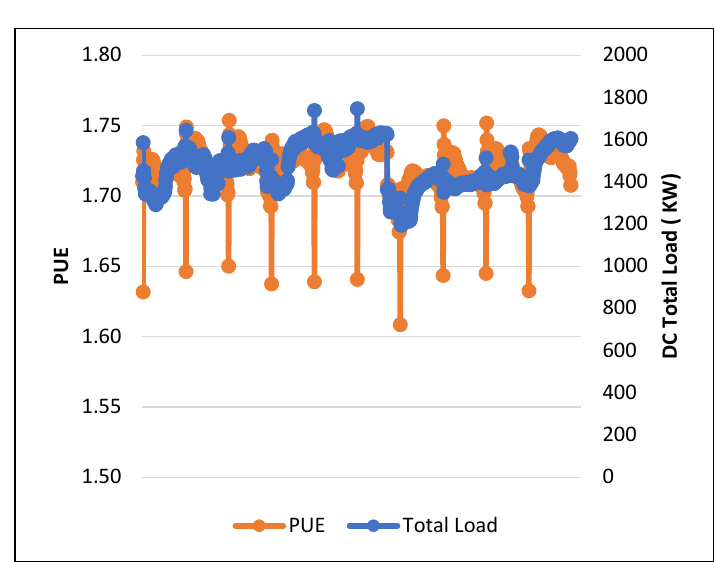
Figure 11. Predicted data PUE vs DC total